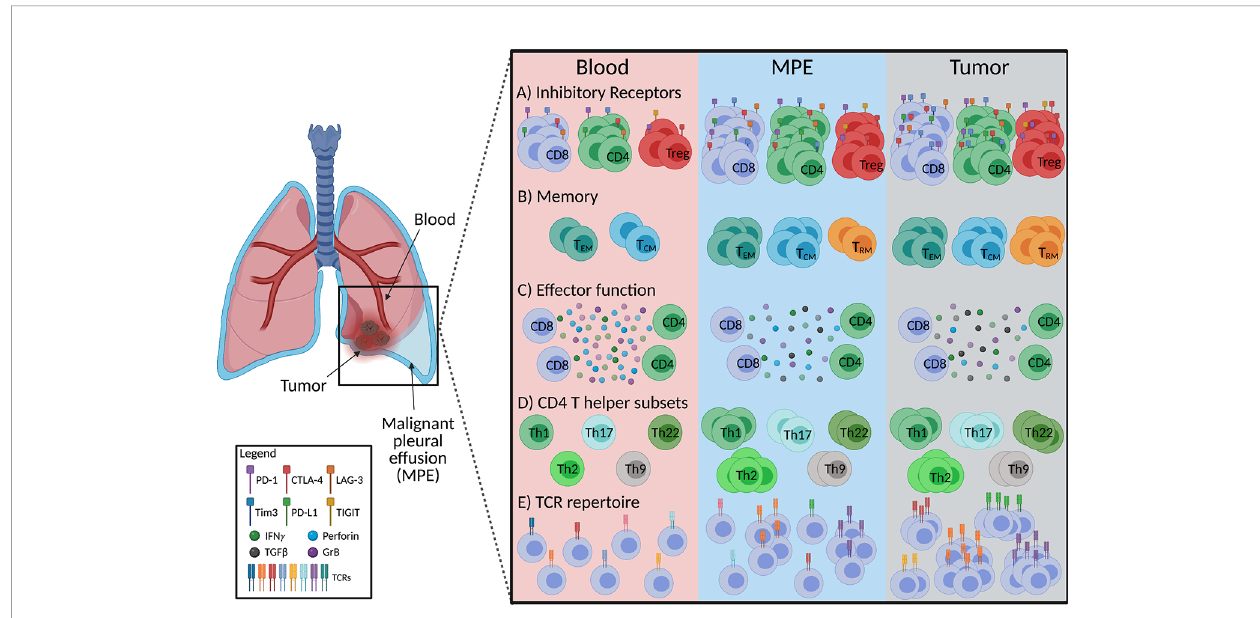
FIGURE 1 | Schematic diagram summarizing characteristics of MPE-derived T cells in comparison to tumor and peripheral blood in mesothelioma and lung cancer. (A) Frequencies of CD8 + , CD4 + and CD4 + regulatory (Treg) T cells expressing inhibitory receptors in the MPE are similar to tumor in fi ltrating T cells, however co- expression of inhibitory receptors on T cells is greater in tumors than MPE. (B) MPE and tumor contain greater proportions of effector memory (T EM ) and central memory (T CM ) T cells than the circulation with tissue resident memory T cell (T RM ) frequencies the greatest at the tumor site. (C) Production of T cell effector cytokines (IFN g , granzyme B; GrB, perforin) are similar between the MPE and tumor in fi ltrating T cells but lower than those in peripheral blood. (D) MPE are likely enriched with a Th2 phenotype along with a greater proportion of Th1, Th2, Th17, Th9, Th22 than circulating T cells, while tumors display a greater frequency of Th17 and Th22 than MPE. Th9 between tumor and MPE is unde fi ned. (E) MPE contains tumor reactive T cells, implying a more clonal T cell receptor (TCR) repertoire than the peripheral blood. Figure created with